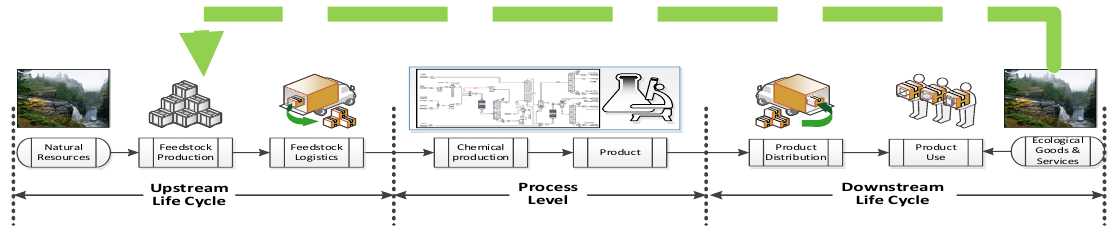
Figure 1. Framework for performing a life cycle analysis of a chemical product.